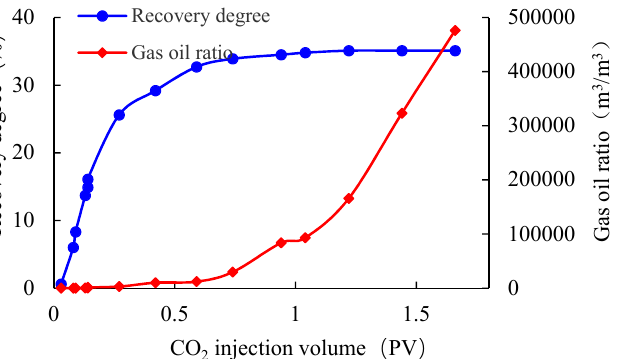
Figure 14. The relationship between CO 2 injected volume and recovery degree, gas–oil ratio (Scheme 1). (2)